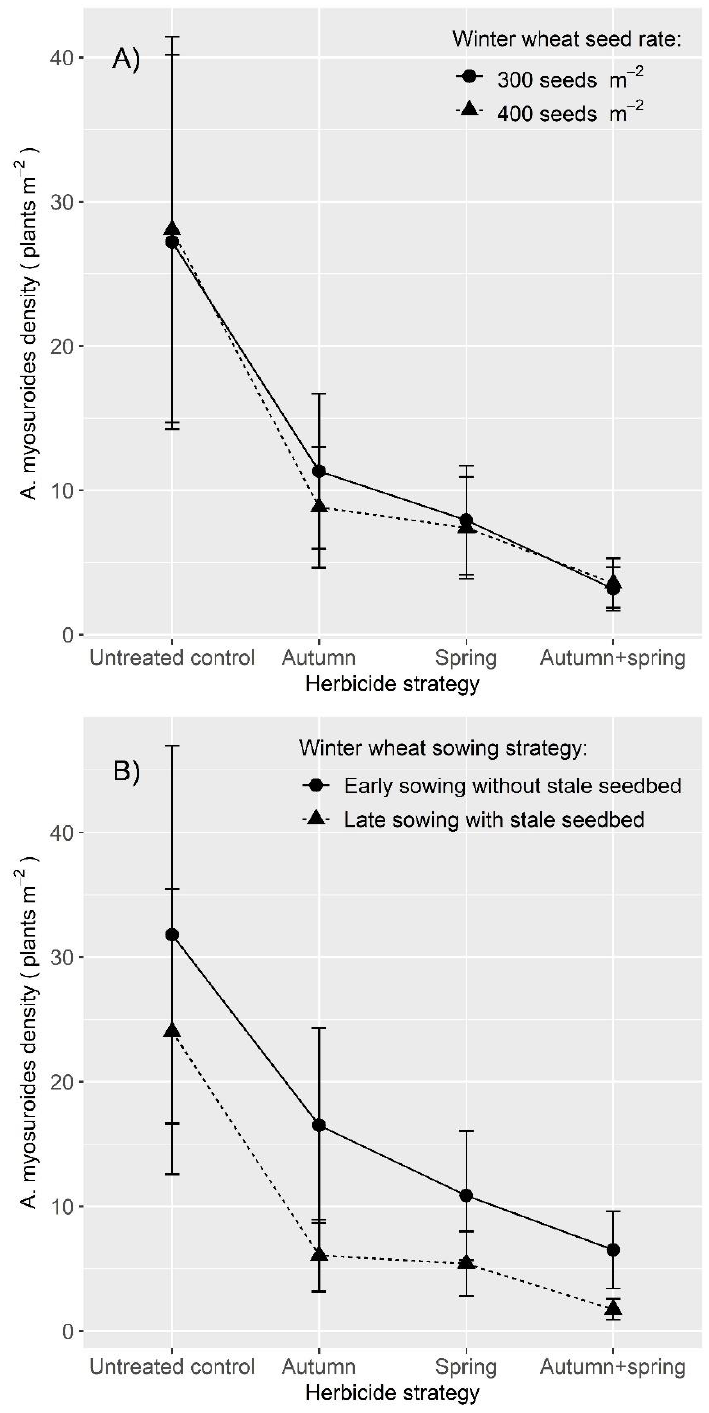
Figure 1. Alopecurus myosuroides plant density as a function of ( A ) herbicide treatment strategy and winter wheat seed rate and ( B ) herbicide treatment strategy and winter wheat sowing strategy.